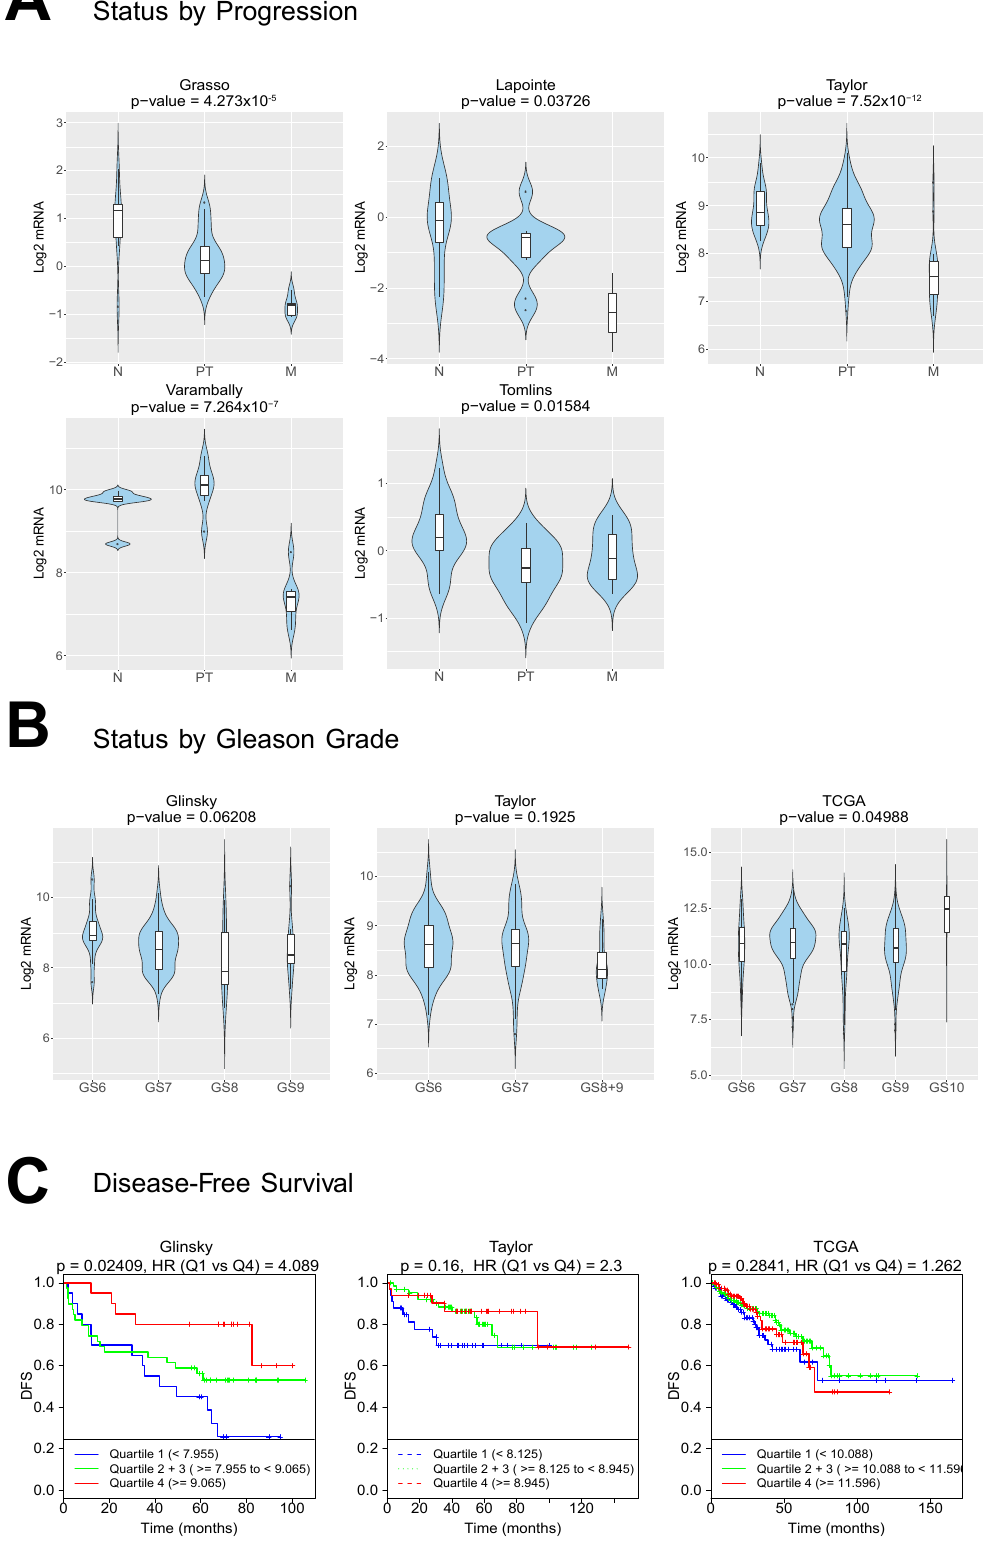
Figure 8. TNC RNA expression is inversely correlated with the disease progression, Gleason score and survival. ( A ) Violin plots depicting the expression of TNC among nontumoral (N), primary tumor